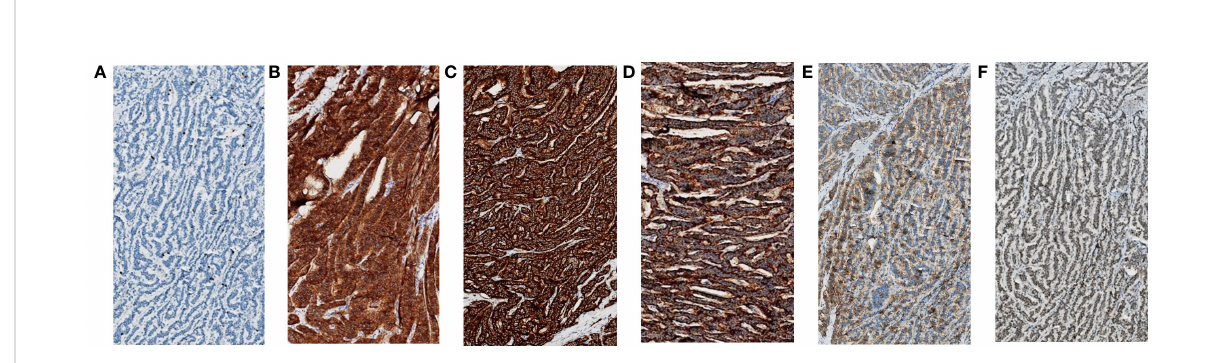
FIGURE 4 Immunohistochemical staining (magni fi cation, x100) of the resected specimen (primary tumor and left LLNs). (A) The Ki-67 index was 1-2%. (B) The CD56 was 3+. (C) The synaptophysin was 3+. (D) The CgA was 3+. (E) The SSTR2 was 2+. (F) The Rb-1 was 2+.